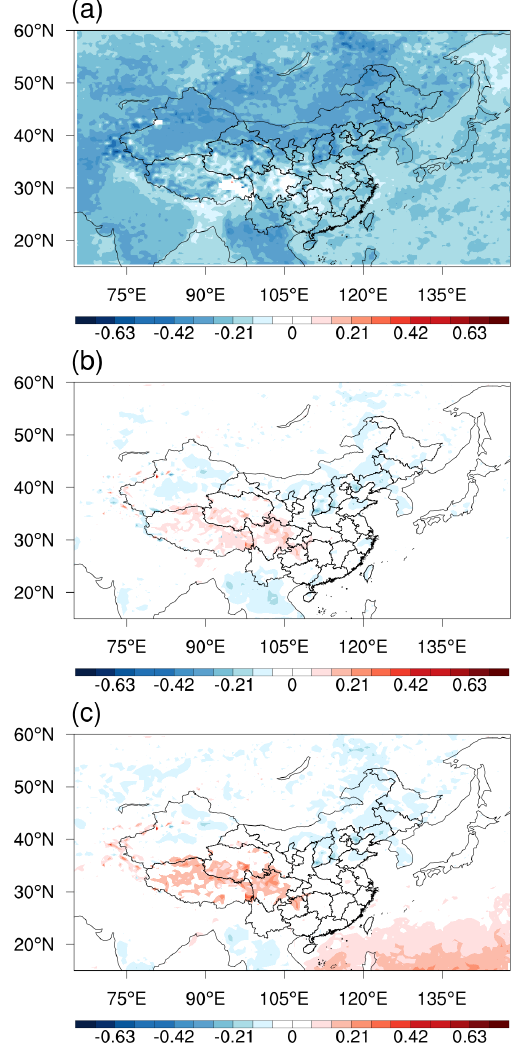
Figure 4. (a) Relative difference between a priori simulation and MOPITT in 2019, calculated by (Model - MOPITT)/MOPITT; (b) same as panel (a) , but with Kalman filter by assimilating MOPITT CO column data; (c) same as panel (a) , but with Kalman filter by assimilating MOPITT CO profile